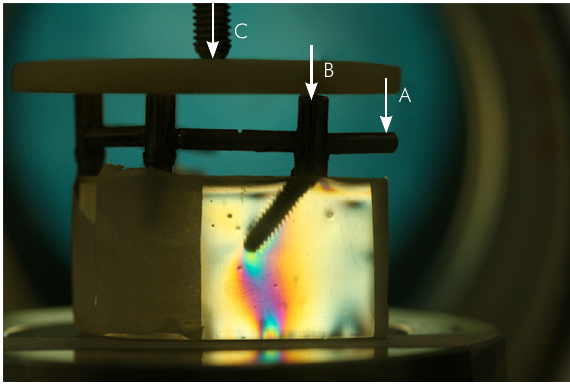
Figure. 3: Different load application to the both groups. A) the end of cantilever, B) the last pillar, C) all pillars at the same